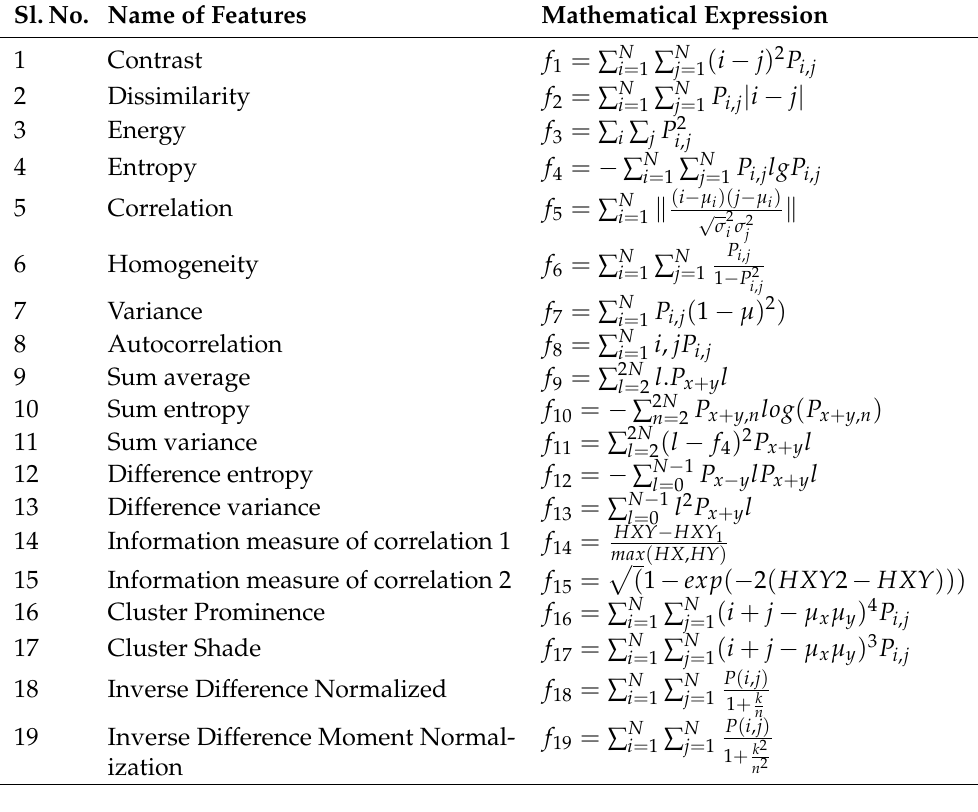
Table 1. Features extracted with their mathematical